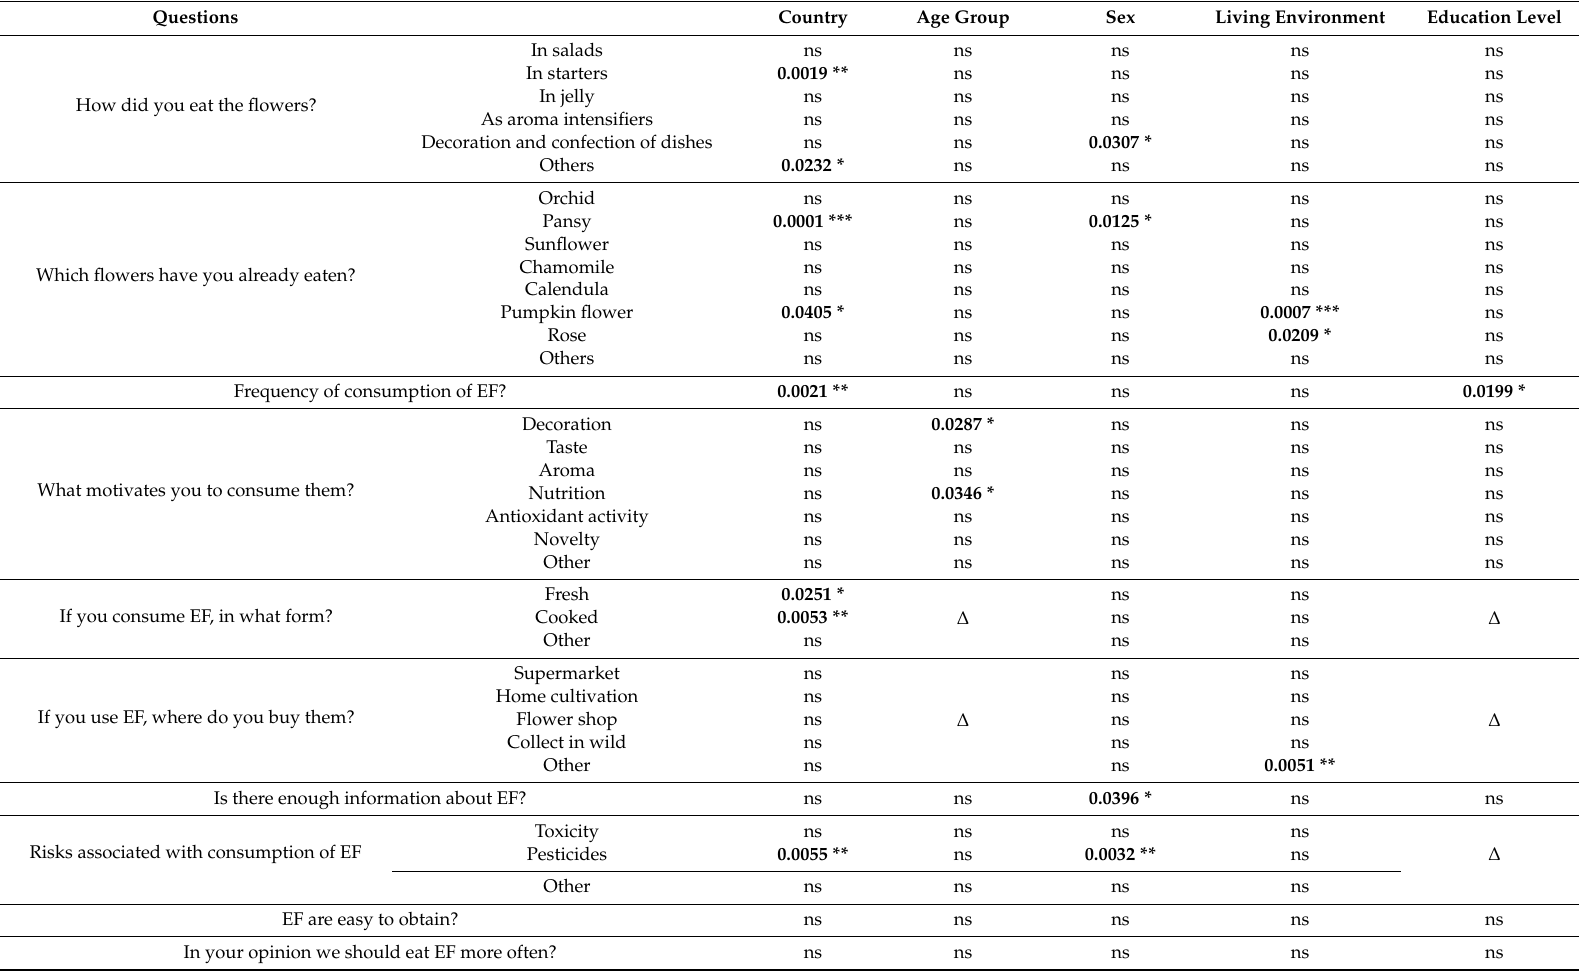
Table 5. Discriminant function analysis summary ( p